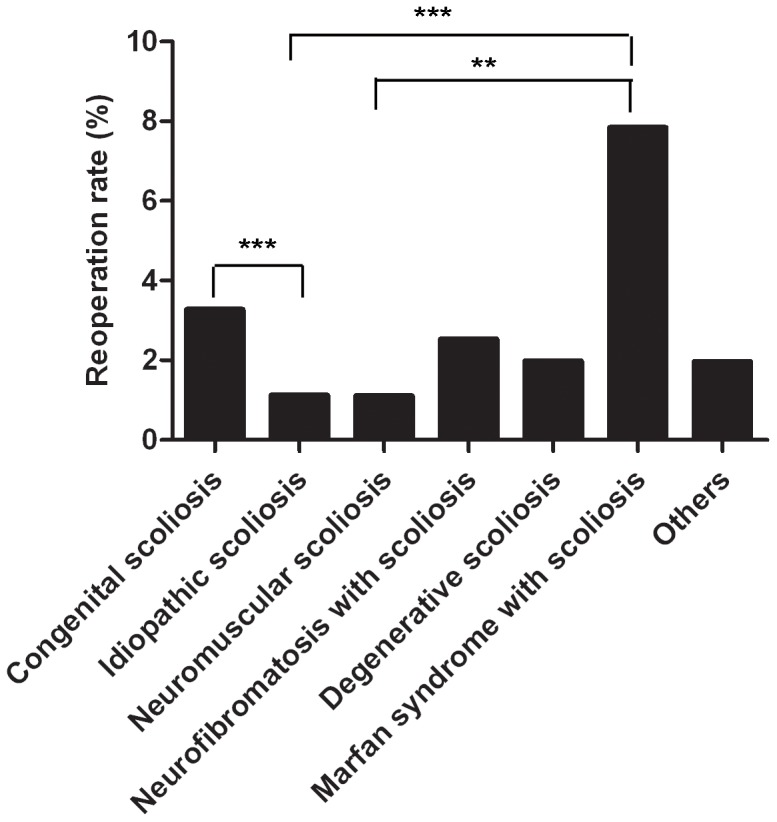
Diagnosis and Reoperation Rates.The statistically significant differences compared with the control are noted as *p<0.05, **p<0.01 and ***p<0.001. Others include syndrome-related scoliosis, ankylosing spondylitis, achondroplasia with scoliosis.